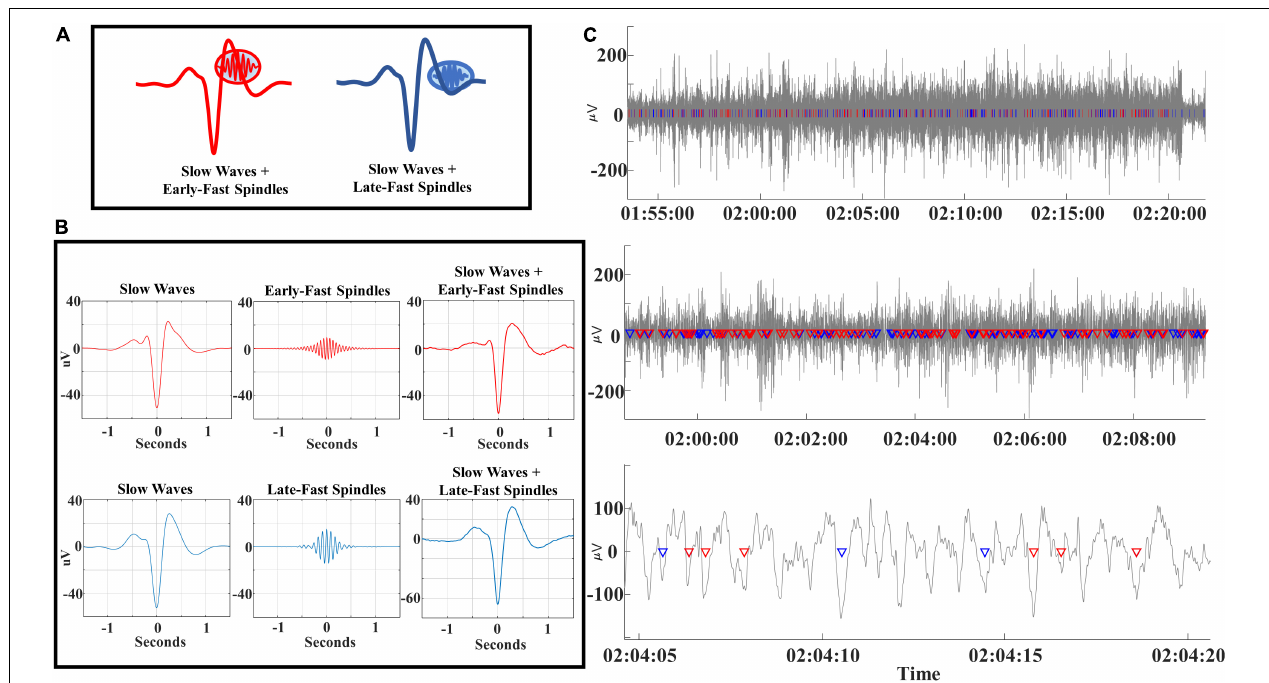
FIGURE 1 | (A) Early-fast and late-fast spindle/slow wave couples are illustrated and color-coded as red and blue, respectively. (B) Original EEG signals for slow waves (bandpass filtered 0.16–4 Hz), early-fast spindles (bandpass filtered 14–18 Hz), late-fast spindles (bandpass filtered 10–13.5 Hz) and coupled slow wave + spindle events (bandpass filtered 0.16–18 Hz) are demonstrated for a single subject (DREAMS Subject 3). (C) EEG time-series data (bandpass filtered 0.16–18 Hz) are from a single subject (DREAMS Subject 3) are graphed at three levels of time duration to demonstrate the intermixing of early-fast spindle/slow waves (red markers) and late-fast spindle/slow waves (blue markers).